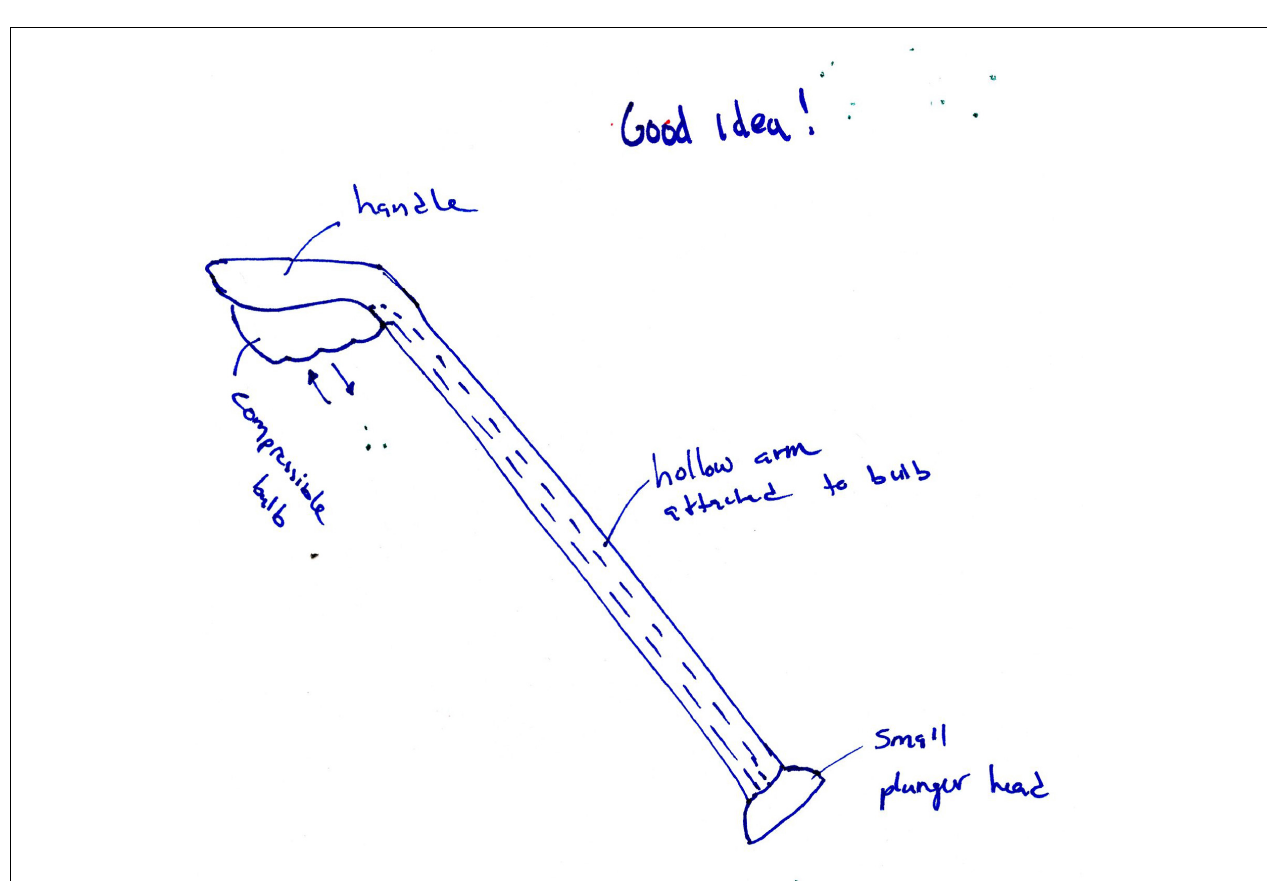
answer would be cheese ( blue cheese , cheesecake , cottage cheese